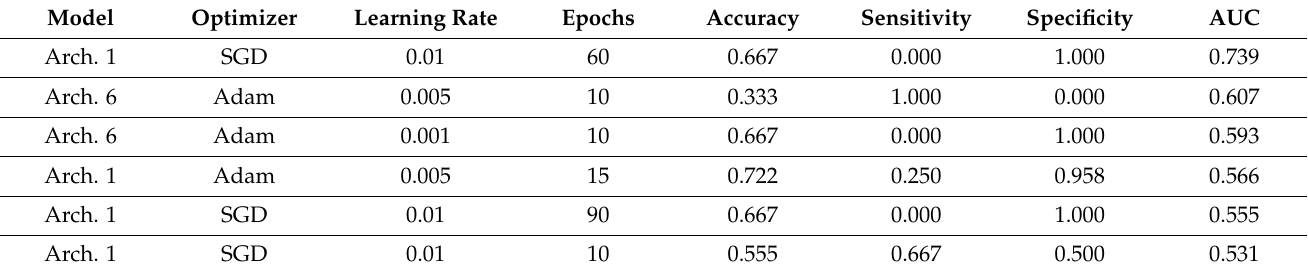
Table 9. KRAS mutation best results on Test dataset, CNNs.